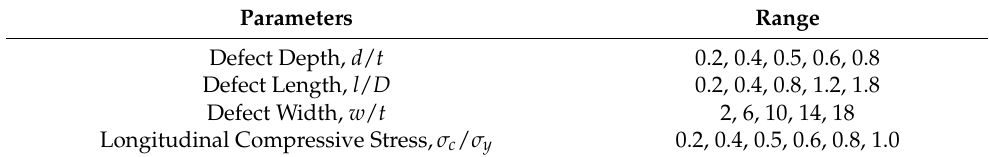
Table 2. Geometric parameters for corrosion defect and load applied to the corroded X65 pipeline.